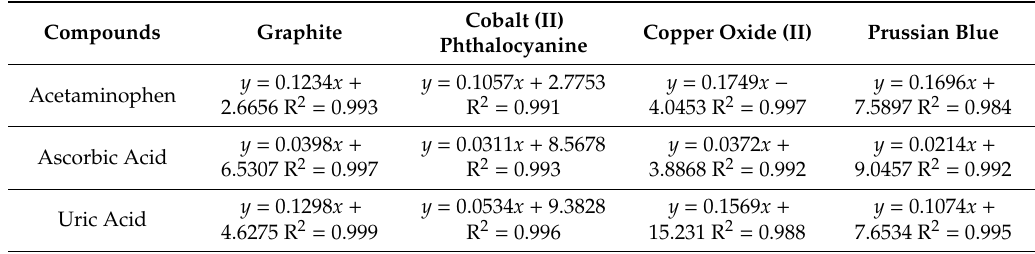
Figure 8. Calibration curves for three replicates (n = 3) to determine the concentration working range for the three compounds under study for the four modified screen-printed electrodes. ( A ) Acetaminophen, ( B ) Ascorbic acid, ( C ) Uric acid. Table 1. Calibration data ( y vs. x ) for the separate determination of Acetaminophen, Ascorbic acid and Uric acid employing the integrated sensor array chosen.